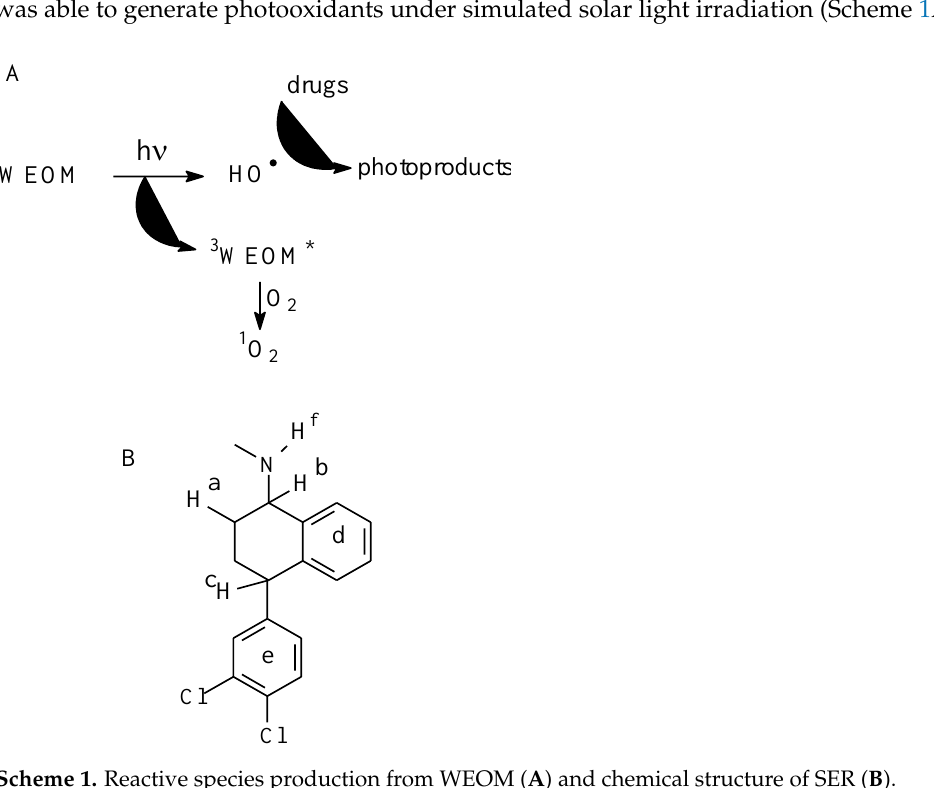
Scheme 1. Reactive species production from WEOM ( A ) and chemical structure of SER ( B ).